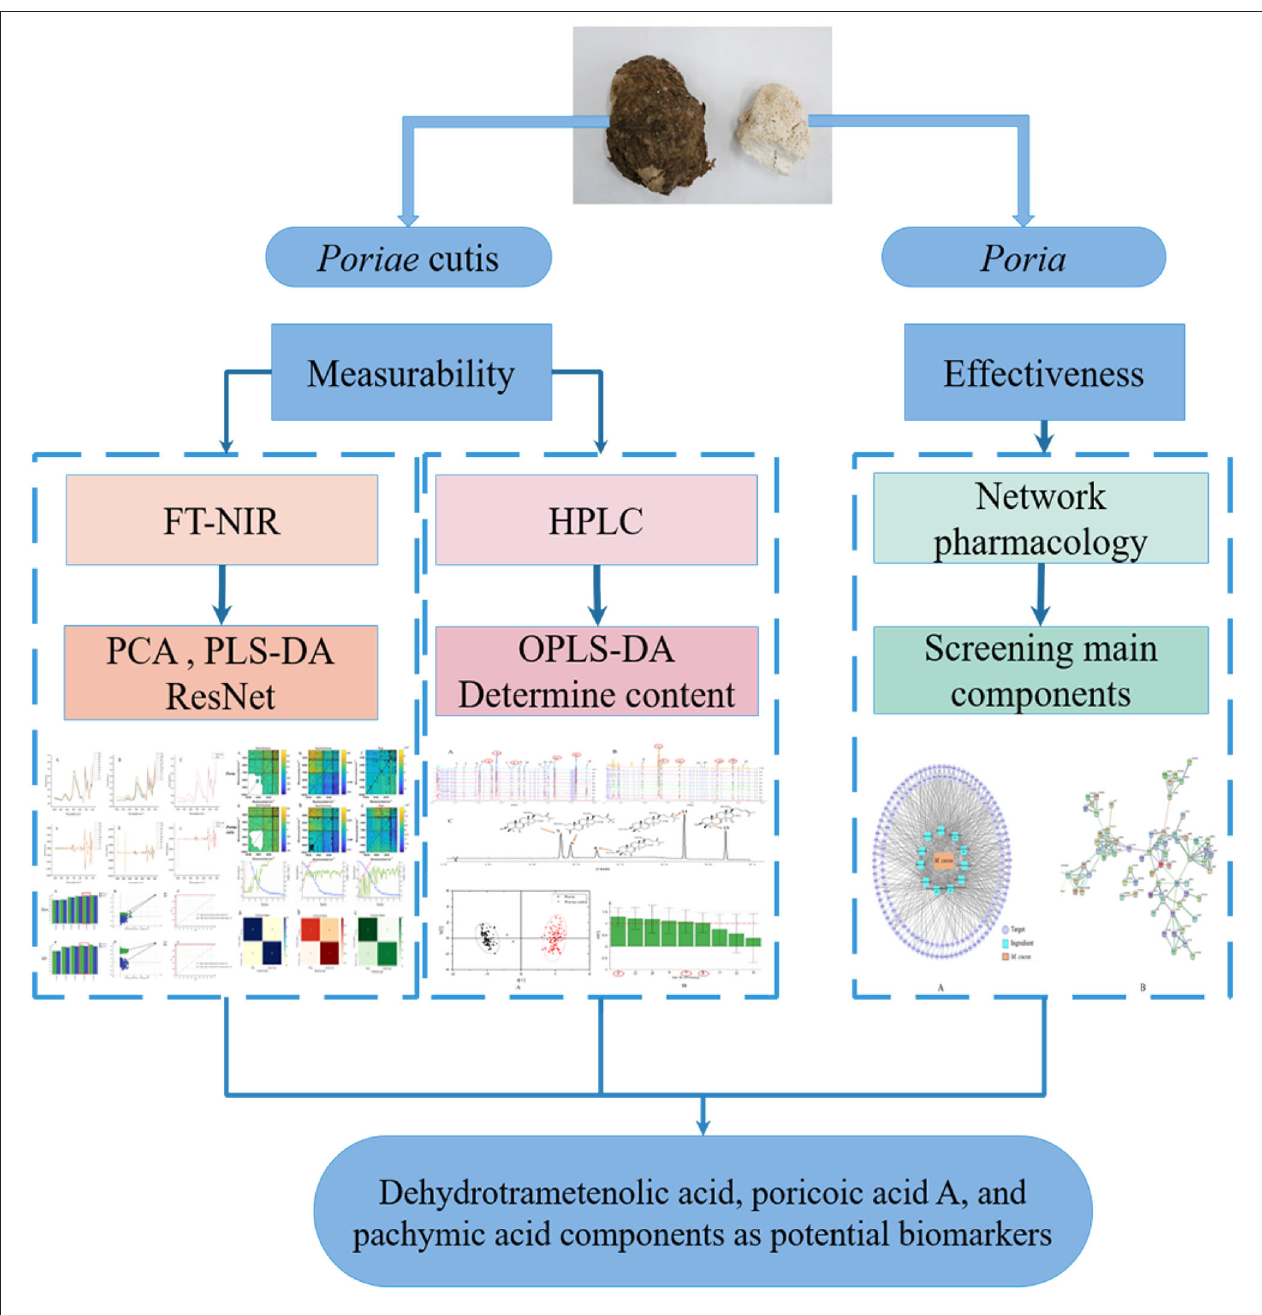
FIGURE 1 | The flow chart of the full